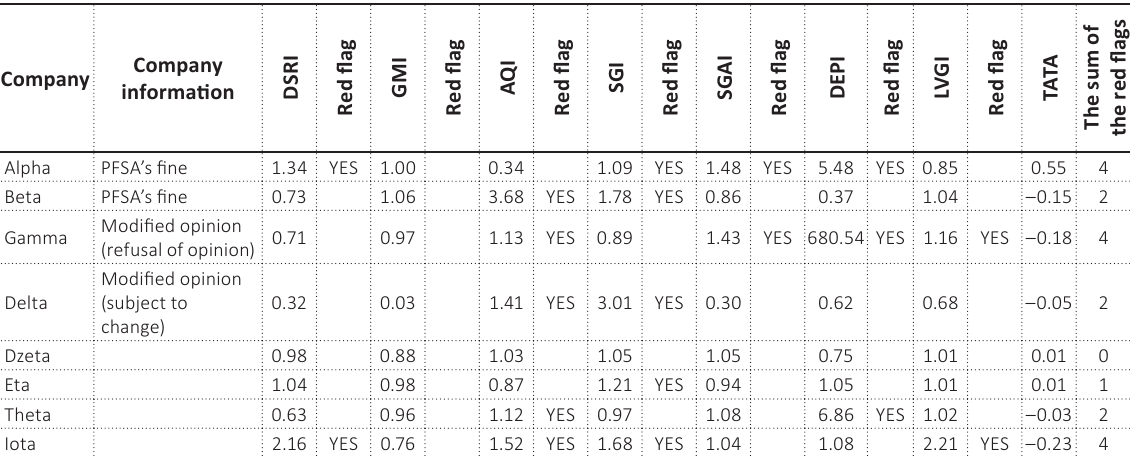
Table 3. Values of indicators from the Beneish model and the number of red flags in the analyzed companies calculated for financial statements prepared for 2010